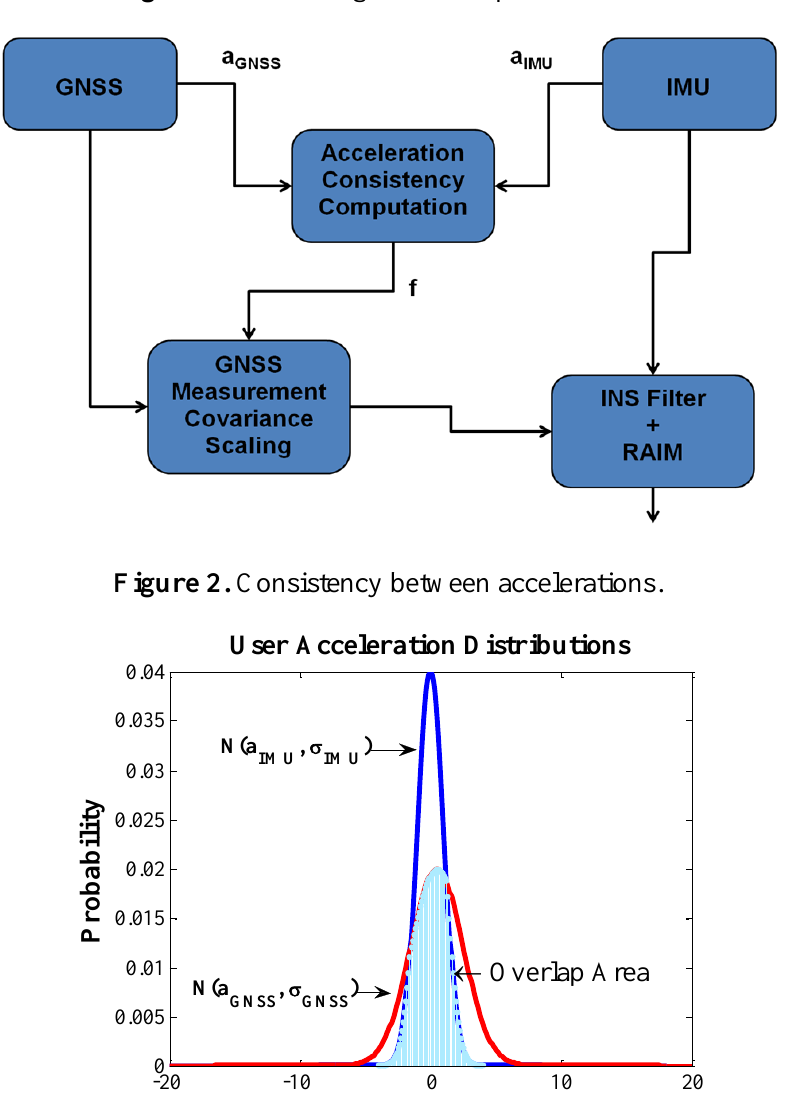
Figure 1. Block diagram of adaptive scheme.